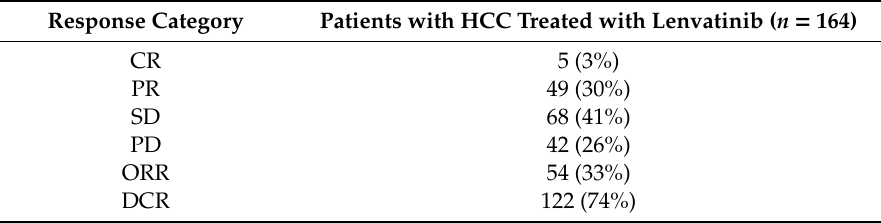
Table 2. Treatment response rate.